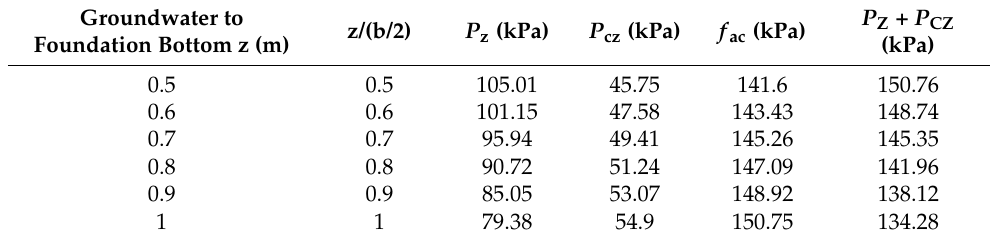
Table 11. Calculation results of foundation bearing capacity (b = 2.0 m, d = 2.25 m). Groundwater to Foundation Bottom z (m)